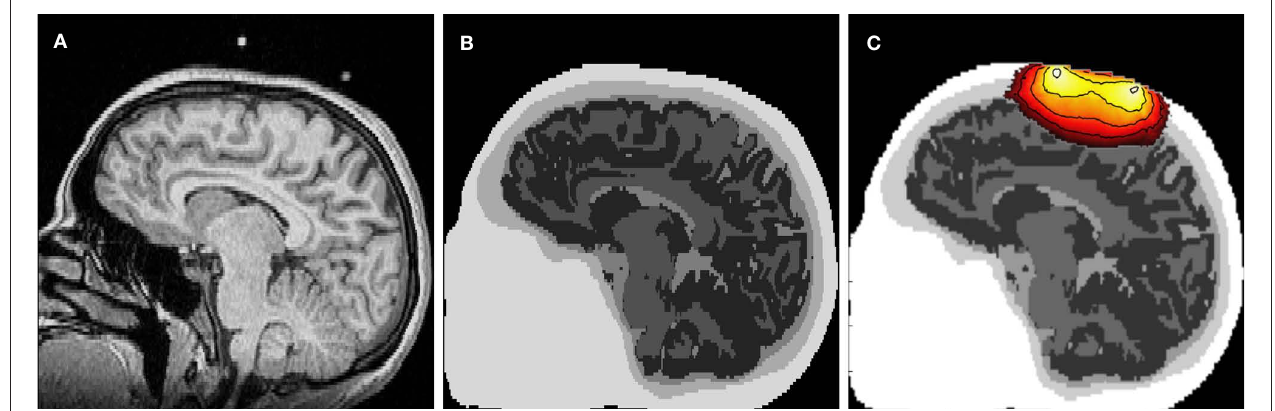
FIGURE 6 | Simulated photon propagation through the head. (A) Typical anatomical MRI scan, with NIN sensor fi ducial markers visible above the scalp. (B) Segmentation of the MRI scan in (A) into separate tissue types where Python was used to chain together the MRI segmentation modules. (C) Example photon densities for a single source–detector pair separated